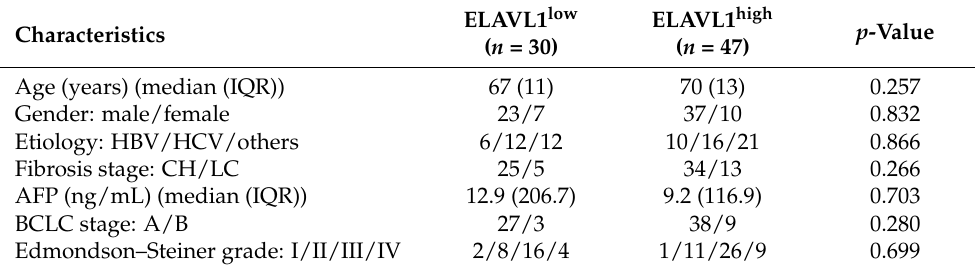
Figure 5. Clinicopathological analyses of ELAVL1 in HCC surgical samples. ( A ) Representative ELAVL1 immunohistochemistry analyses for tumor and adjacent non-tumor tissues. Scale bar = 100 µ m. ( B ) Calculation of ELAVL1 expression patterns in tumor and adjacent non-tumor tissues. ( C ) Cumulative progression-free survival based on the ELAVL1 expression in all HCC patients ( n = 77) (Log-rank test, p = 0.08). ( D ) Cumulative RFS rate based on the ELAVL1 expression in HBV-related HCC patients ( n = 16) (Log-rank test, p = 0.06). Table 1. Clinical features of ELAVL1 low and ELAVL1 high HCC patients.